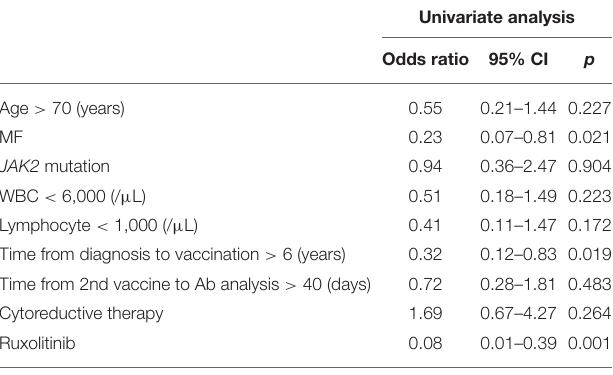
TABLE 2 | Univariate analysis for obtaining protective levels of antibody to COVID-19 infection after two doses of